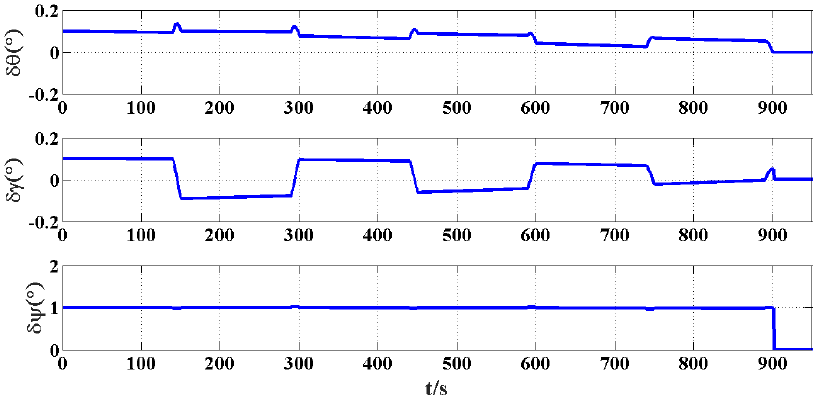
Figure 10. Attitude error of in-motion alignment of trapezoidal maneuver.